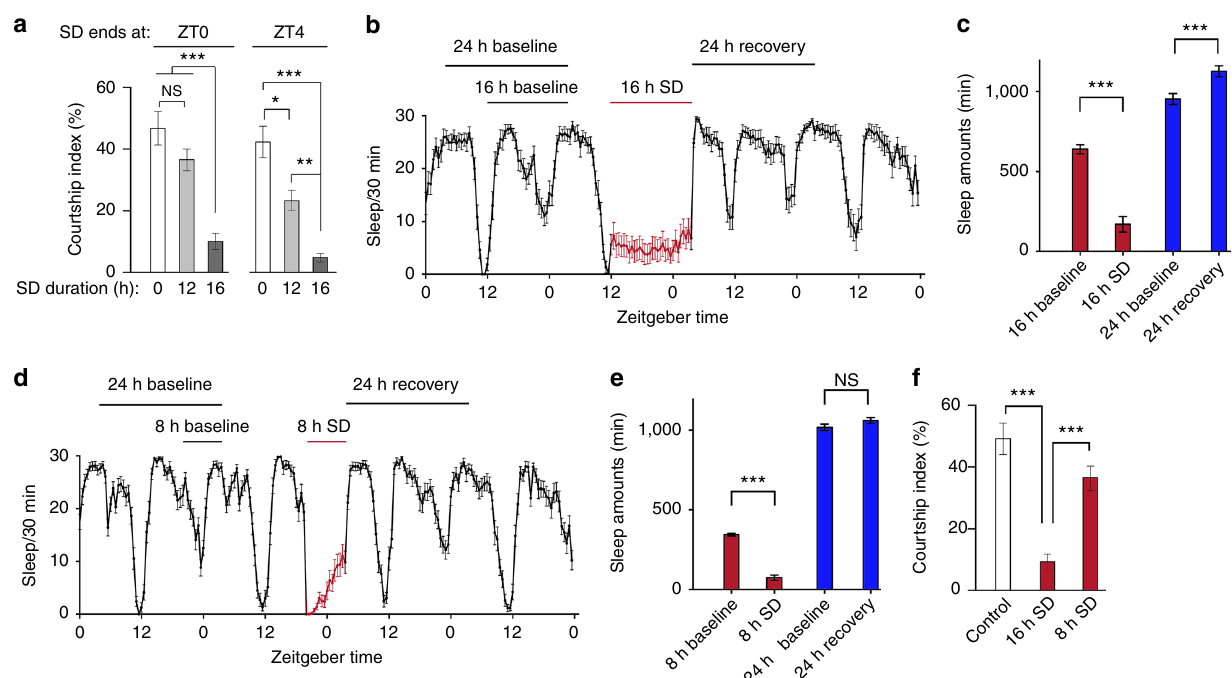
Fig. 1 SD suppresses male courtship. a Courtship indices of males that had been sleep-deprived for 12 h ( light gray ) or 16 h ( dark gray ) during indicated periods. n = 24 for each. * p < 0.05, ** p < 0.01, and *** p < 0.001, one-way ANOVA. b Detailed sleep pro fi le of male fl ies with 16-h SD (15 s/min shaking). c The 16-h SD results in 468-min sleep loss during SD and induces post-SD sleep rebound. The start point of baseline was chosen at the same ZT the day before SD. n = 32. *** p < 0.001, unpaired t- test. d Detailed sleep pro fi le of male fl ies with 8-h SD (30 s/min shaking), but the amount of mechanical perturbation is the same as the above 16-h SD. e The 8-h SD results in 269-min sleep loss during SD, and does not induce post-SD sleep rebound. n = 32.